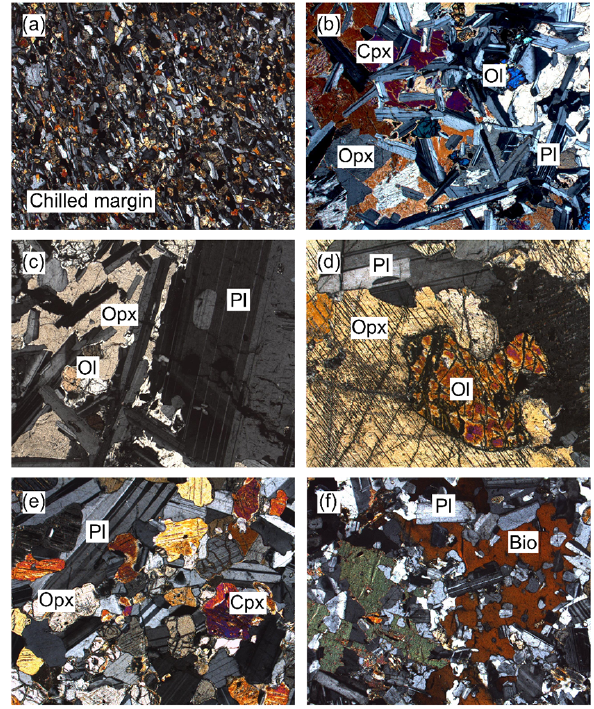
Figure 3. Cross-polarised light images of gabbroic rocks; all im- age field of views are 2mm. (a) Chilled, flow-foliated margin of the Days Creek Gabbro DC65. (b) Ophitic micro-gabbro in Bar- ney House Gabbro BH30. (c) Phenocrystic plagioclase in Barney House gabbro BH45. (d) Relict olivine in massive Days Creek Gab- bro DC19. (e) Granular Days Creek Gabbro DC36. (f) Poikilitic biotite–diorite associated with Days Creek Gabbro